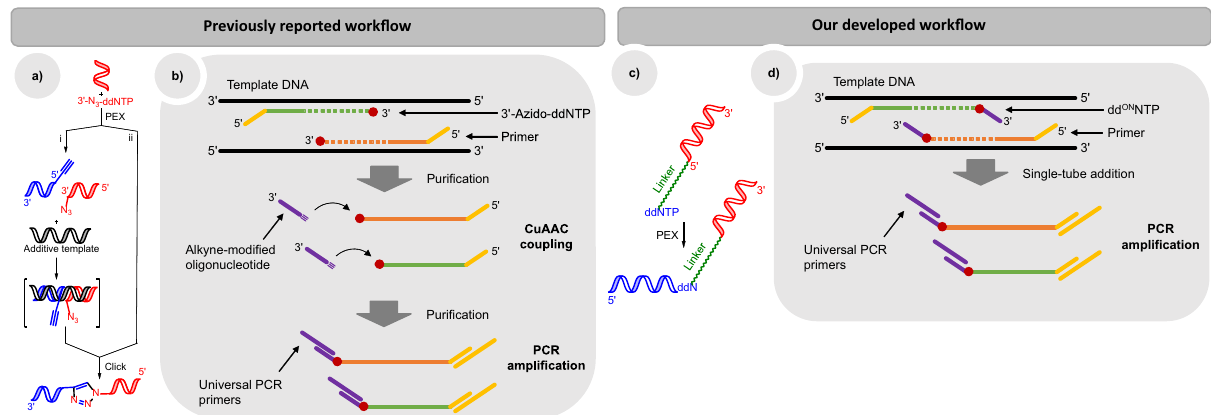
Fig. 1 Comparison of library preparation strategies. Previously reported work fl ow: a schematic representation of chemical ribose-to-ribose ligation: i) templated click reaction; ii) non-templated click reaction, b work fl ow for NGS library preparation using ribose-to-ribose ligation. Our reported work fl ow: c schematic ligation, PEX/termination by dd ON NTP and d NGS library preparation work fl ow using dd ON NTP